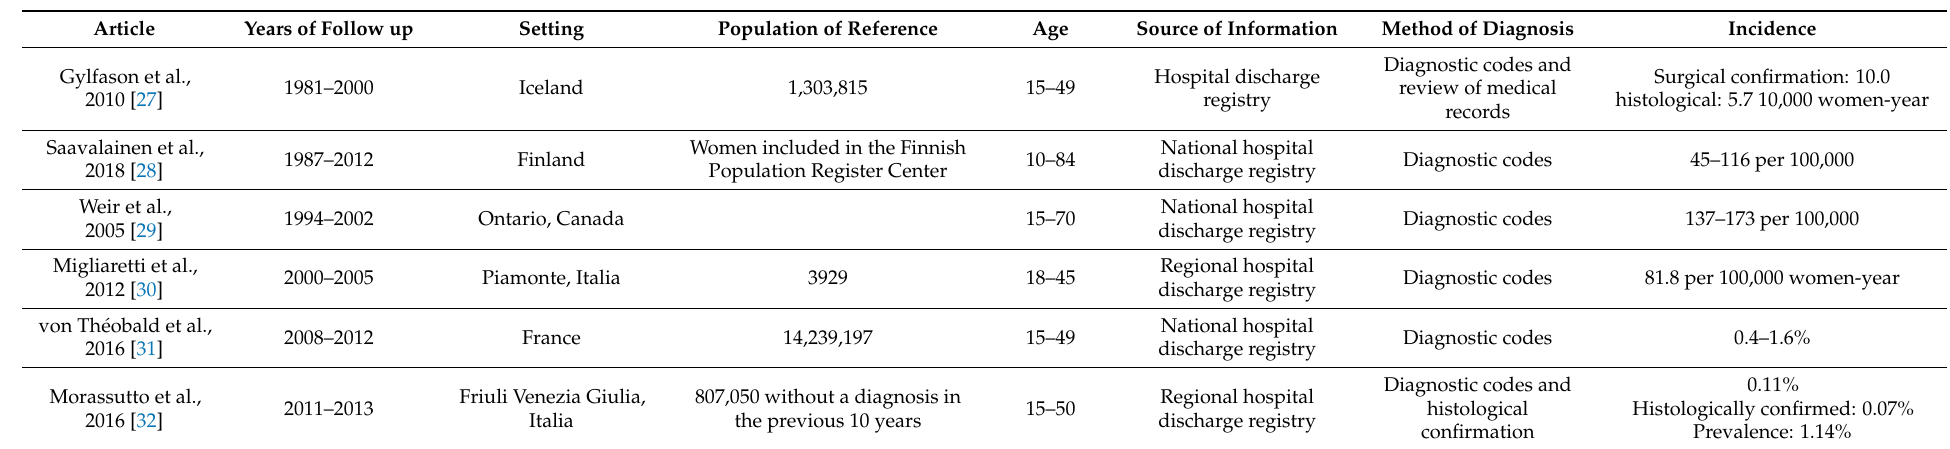
Table 4. Hospital